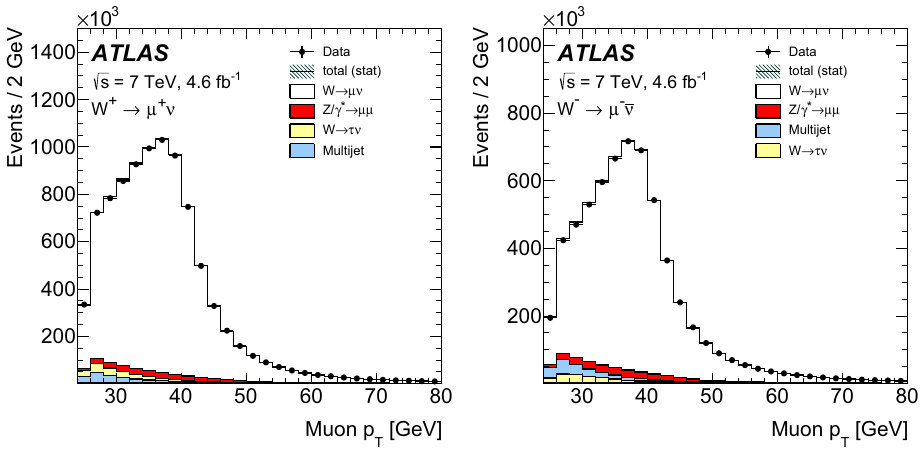
Fig. 10 The transverse momentum distribution of muons for W + → μ + ν candidates ( left ) and W − → μ − ¯ ν candidates ( right ). The simu- lated samples are normalized to the data luminosity. The multijet back- ground shape is taken from a data control sample and normalized to